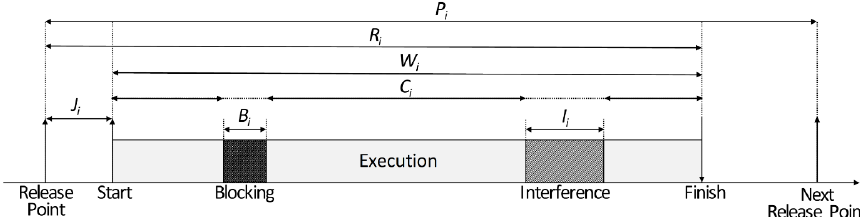
Figure 2. Timeline describing the behavior of a real-time task with a given response time and period.